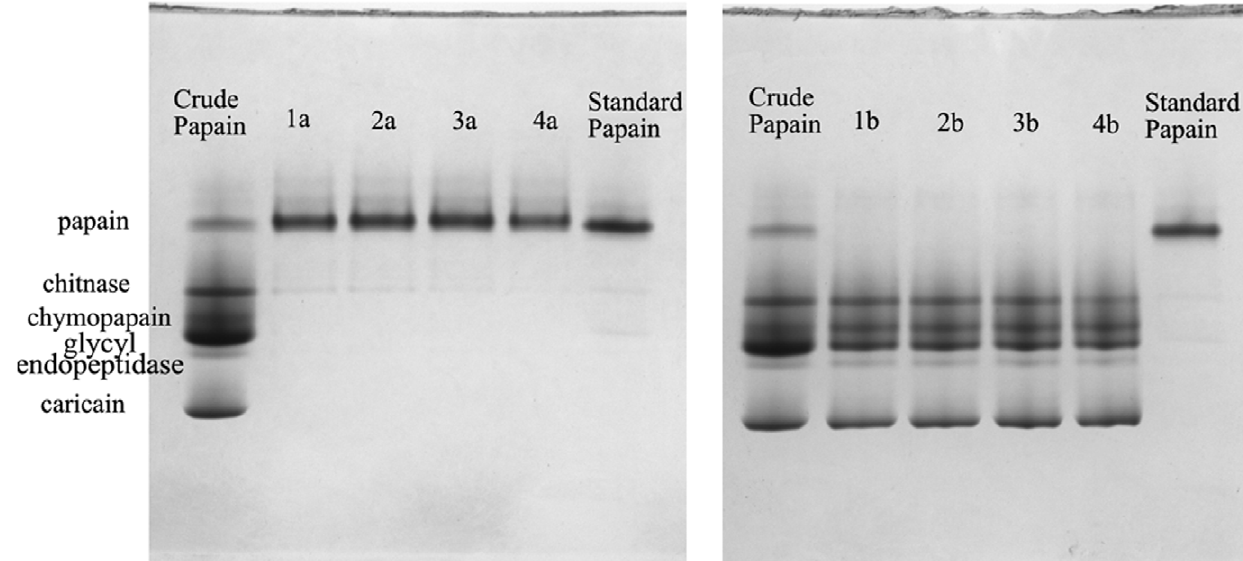
Figure 1. Native-PAGE of papain during extraction in ATPS: 1a-4a corresponding to the run number of Table 3 represented the PEG phase of ATPS; 1b-4b corresponding to the run number of Table 3 represented the salt phase of ATPS; Crude papain: spray-dried latex powders; Standard papain: 2 6 crystallized papain. All the samples were loaded 10 m g. doi:10.1371/journal.pone.0015168.g001 PLoS ONE |